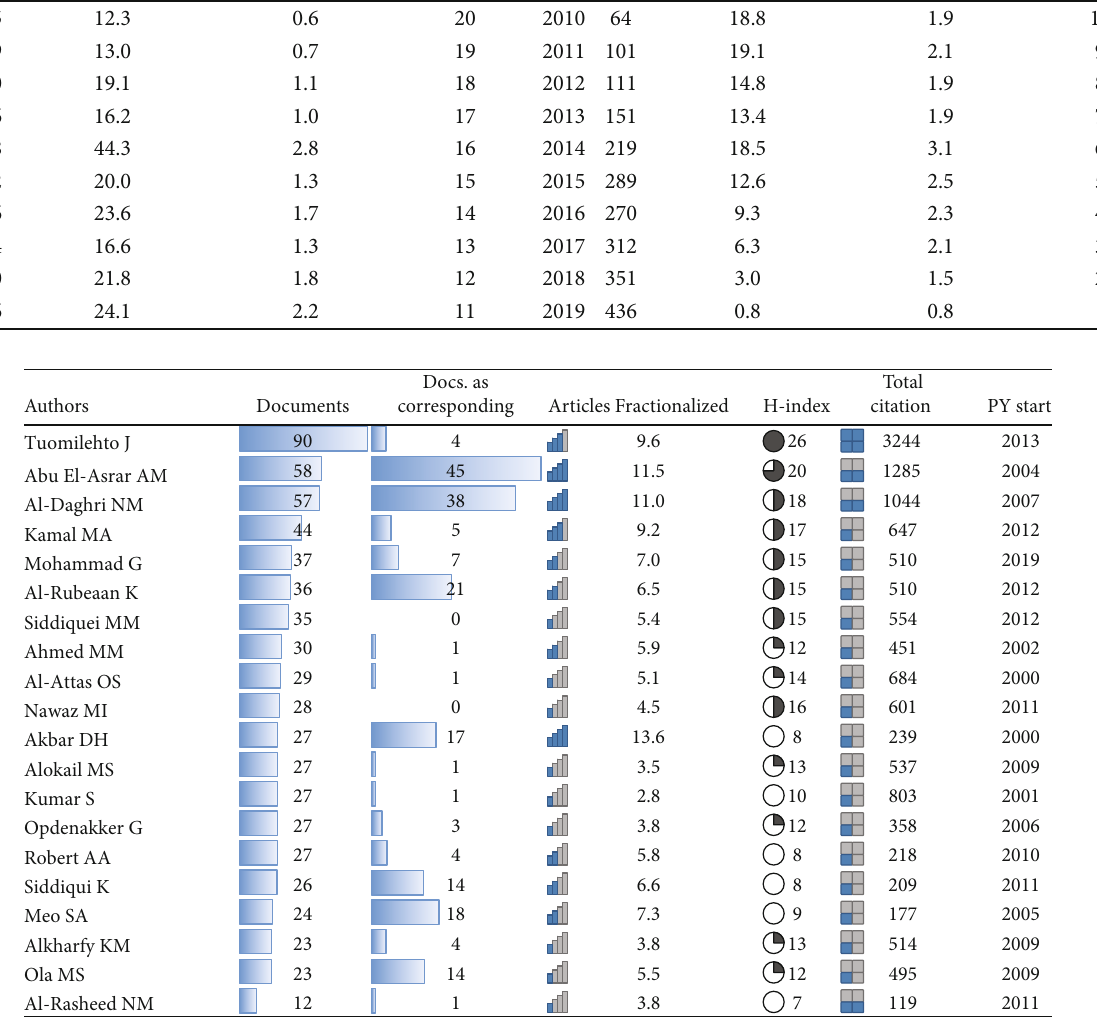
Figure 1: Top 20 most productive authors with authors ’